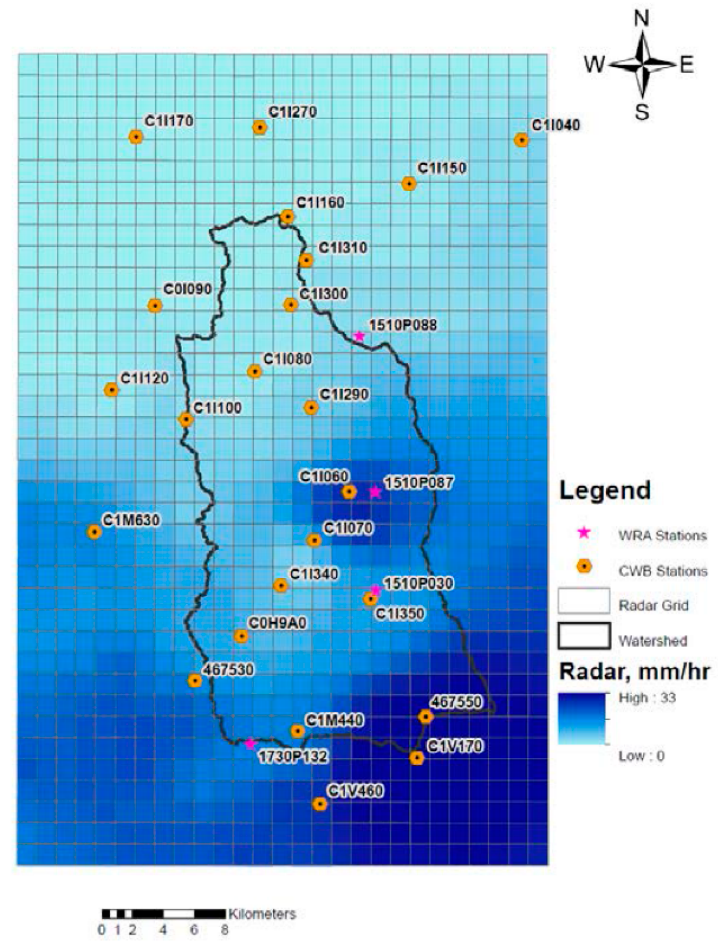
Figure 3. Sample time slice of the unadjusted quantitative precipitation estimation and segregation using multiple sensors (QPESUMS) radar rainfall data from Typhoon Morakot in August 2009.